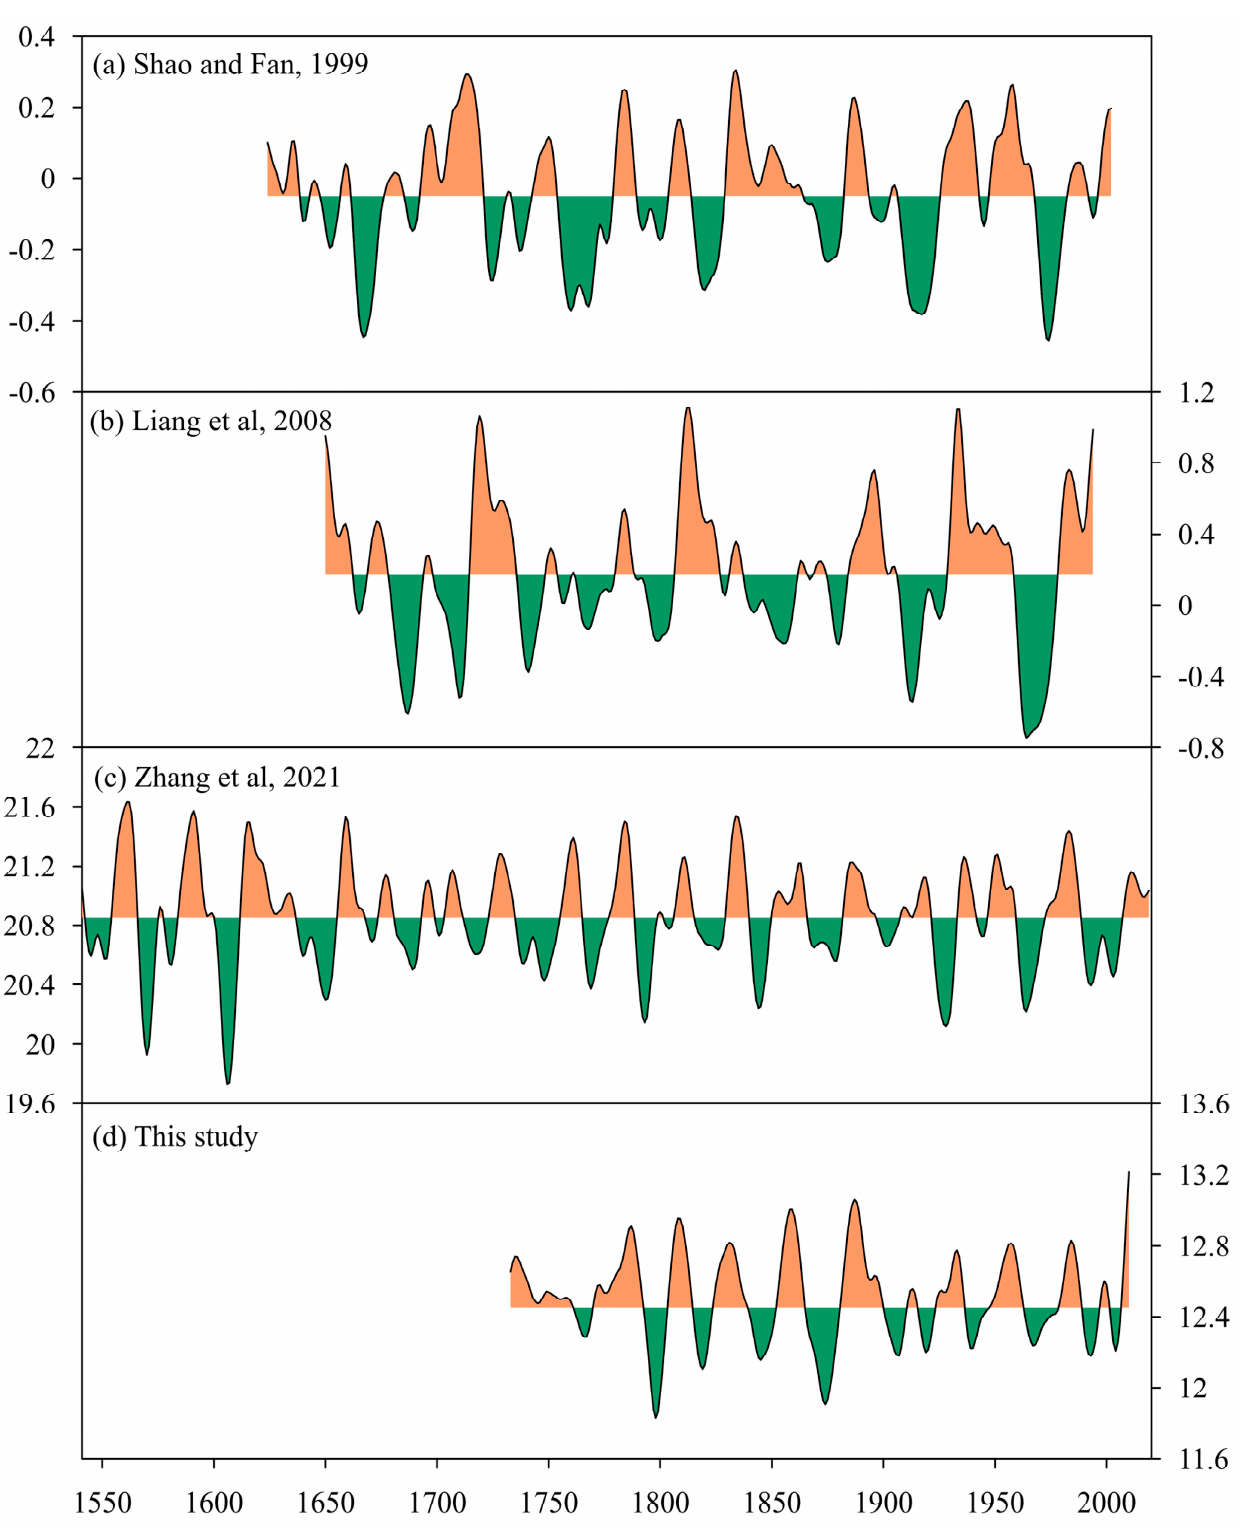
Figure 8. Comparisons between our reconstruction and other proxies: ( a ) PC1 series reflecting mean minimum temperatures in the WSP [42]; ( b ) the anomaly series of mean minimum temperatures in summer in the Yangtze River headwater region [33]; ( c ) the mean maximum temperature in May and June in the southeastern Qinghai–Tibet Plateau [17], and ( d ) the reconstructed mean summer minimum temperature of the present study. Here, 11-year Gaussian low-pass filtering was performed for all series.